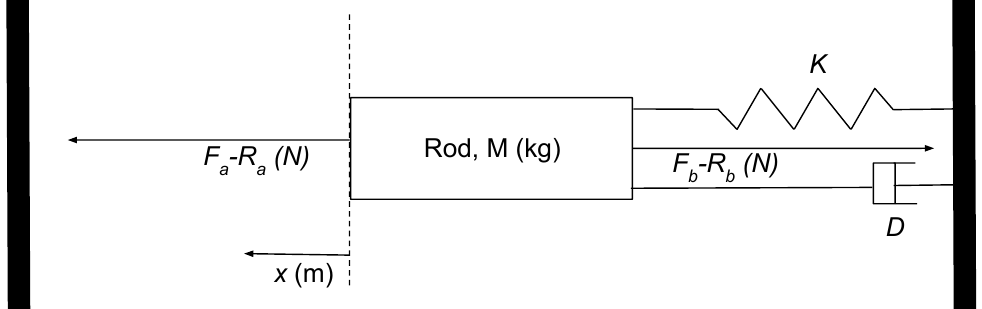
Figure 6. Dynamic model of the TMM servo actuator. Reprinted by permission from Springer Nature: Springer eBook [42], copyright